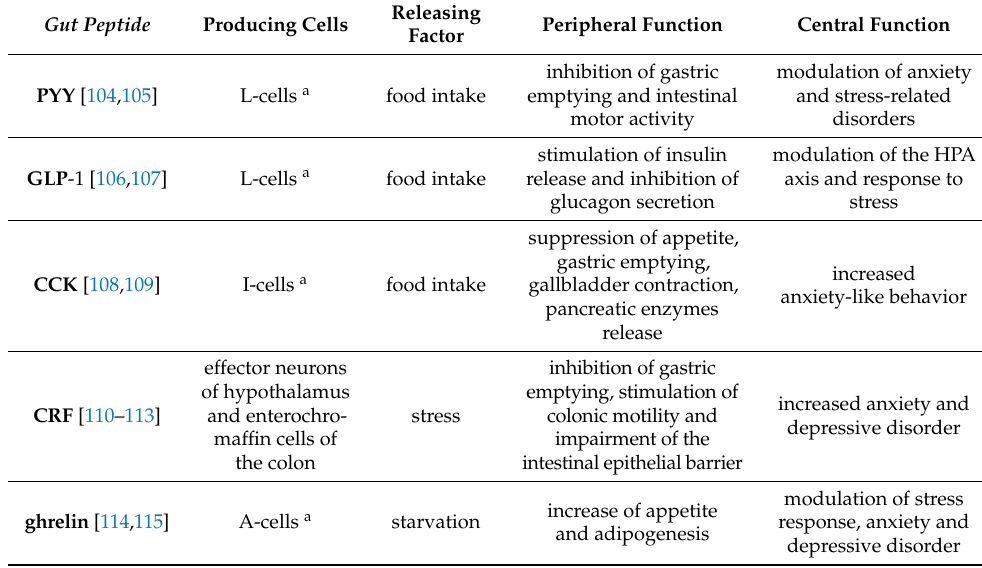
Table 3. The most important gut peptides and their characteristics (HPA—hypothalamic-pituitary-